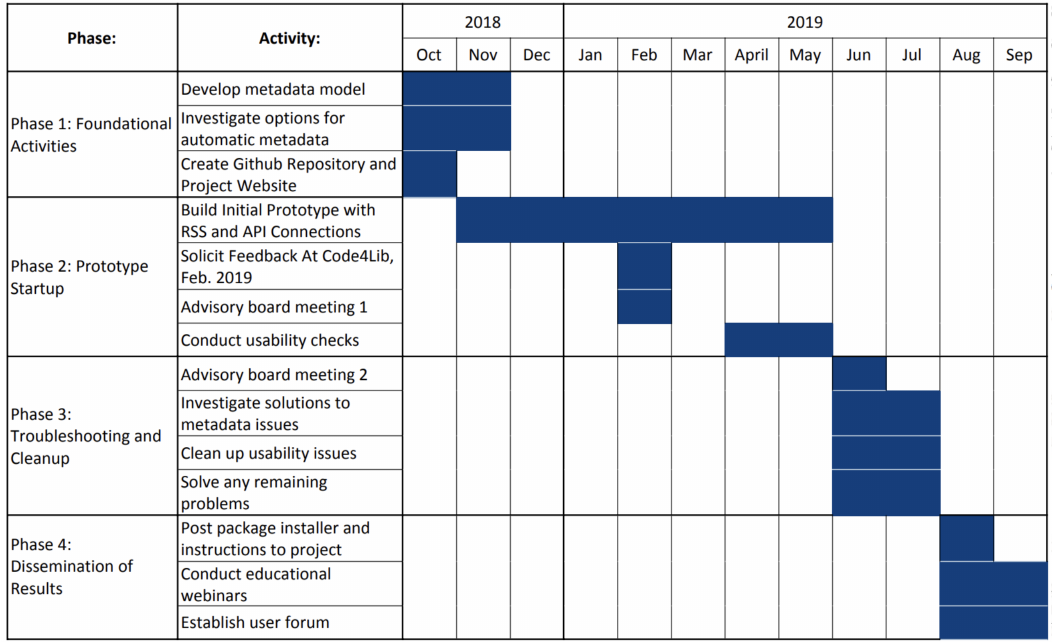
Figure 2. The timeline for the Dataset Search